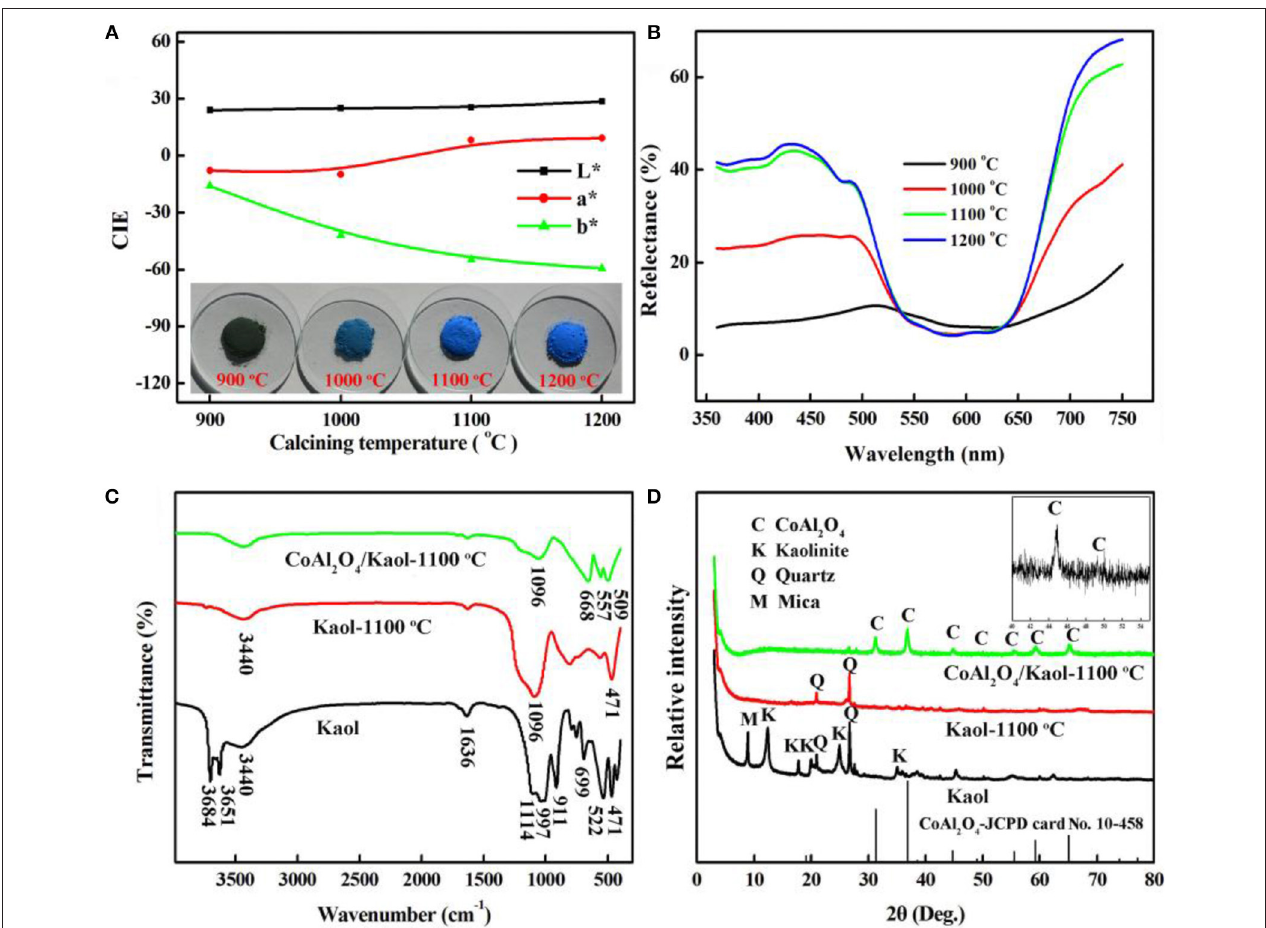
FIGURE 1 | (A) CIE parameters and (B) reflectance spectra of CoAl 2 O 4 /Kaol hybrid pigments calcined at different temperatures, (C) FTIR, and (D) XRD patterns of Kaol, Kaol-1100 ◦ C, and CoAl 2 O 4 /Kaol-1100 ◦ C (the insert is the partial enlarged view of XRD patterns).